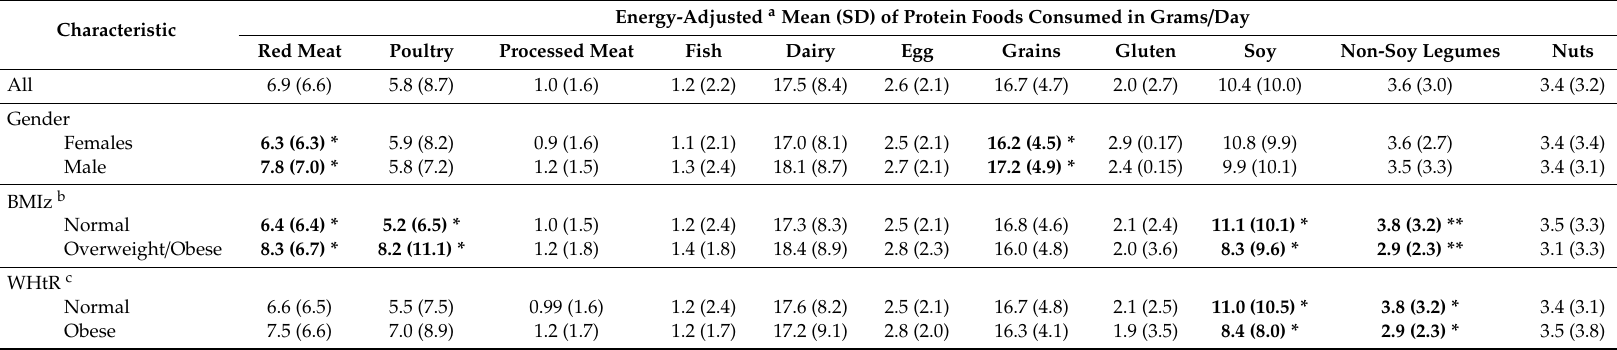
Table 4. Estimated energy-adjusted means (SD) of animal and plant protein foods intake in g / d according to gender, weight status, and central adiposity. Energy-Adjusted a Mean (SD) of Protein Foods Consumed in Grams / Day Characteristic Red Meat Poultry Processed Meat Fish Non-Soy Legumes Nuts